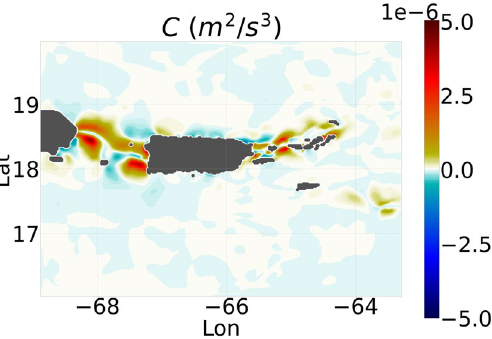
Figure 6. Depth-averaged conversion rate C of barotropic to baroclinic energy, averaged over 1 month in April. The averaging over 1 month is done to minimize the mesoscale and submesoscale perturbations. Details on the term C are provided in Online Appendix